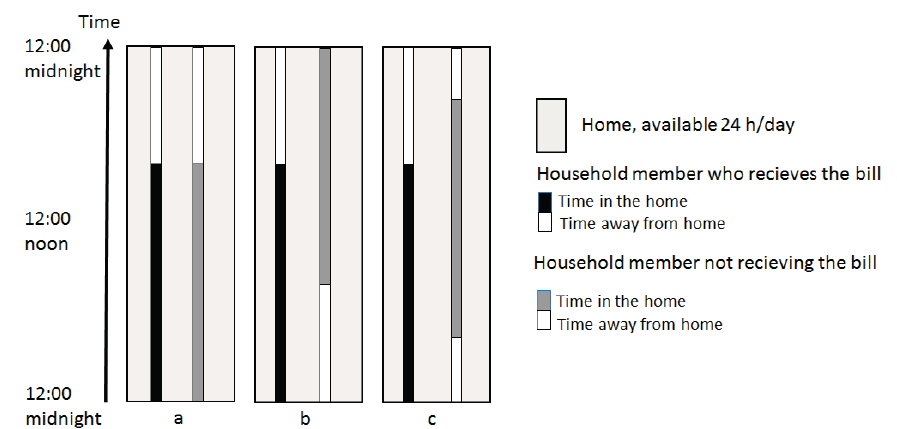
Figure 2. Three home-use patterns in two-person households in which each household member spends 65% of his/her time at home (the large light grey rectangles). Each person is represented by a bar extending over time within the home; the bar is shaded (black or grey) when the person is at home and white when the person is away from home. The bar, which is partly in black, indicates the person billed by the energy company and the bar partly in grey, the other household member. ( a ) shows two individuals with exactly the same pattern of being at and away from their common home, leaving the home empty for 35% of the day (they use the home simultaneously); ( b ) shows that even if the two people are at home for exactly the same amount of time ( i.e. , 65% of the day) as in ( a ), the home is never empty because the household members’ time at home overlaps; and ( c ) shows that the two household members spend 65% of their time at home, parts of their time at home overlapping, leaving little time when the home is